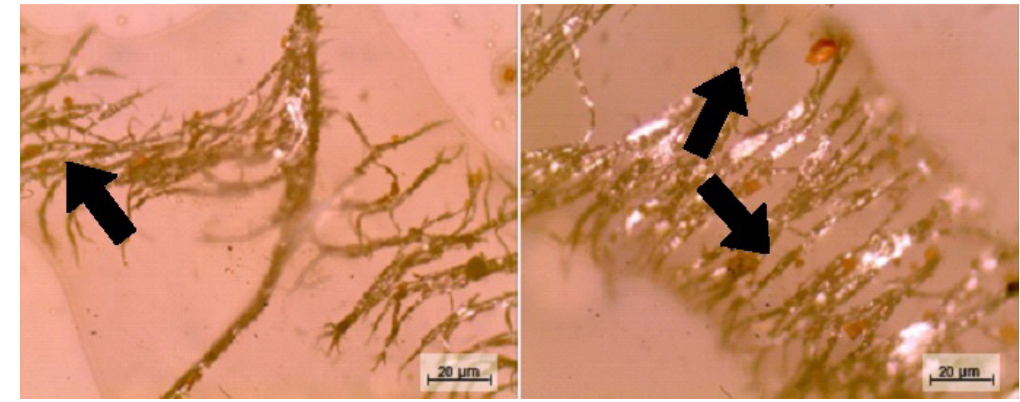
Figure 9. Contaminated blade with 2% left and 5% right. Source: Author’s own elaboration.